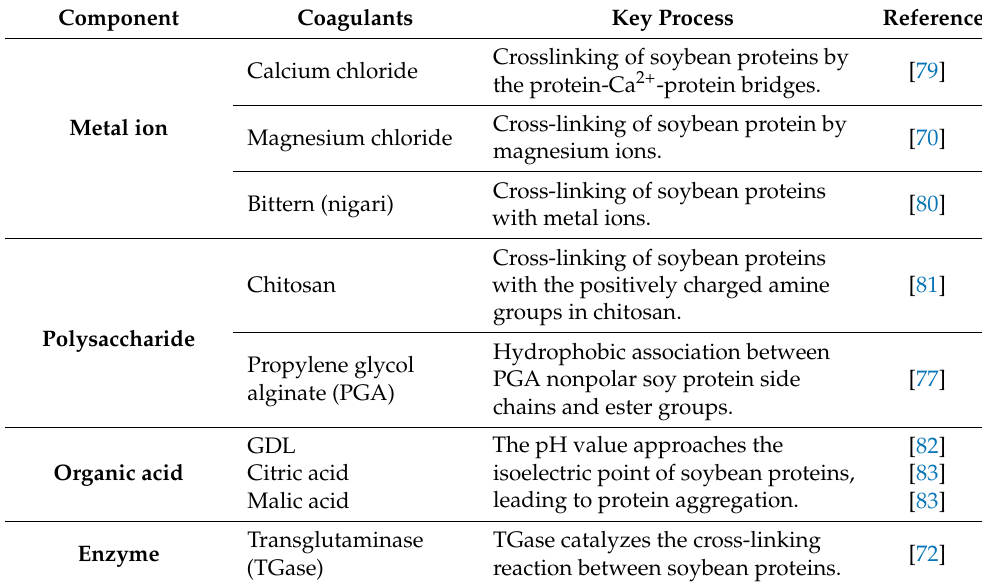
Table 3. Coagulation of denatured soybean proteins in soymilk using coagulants.